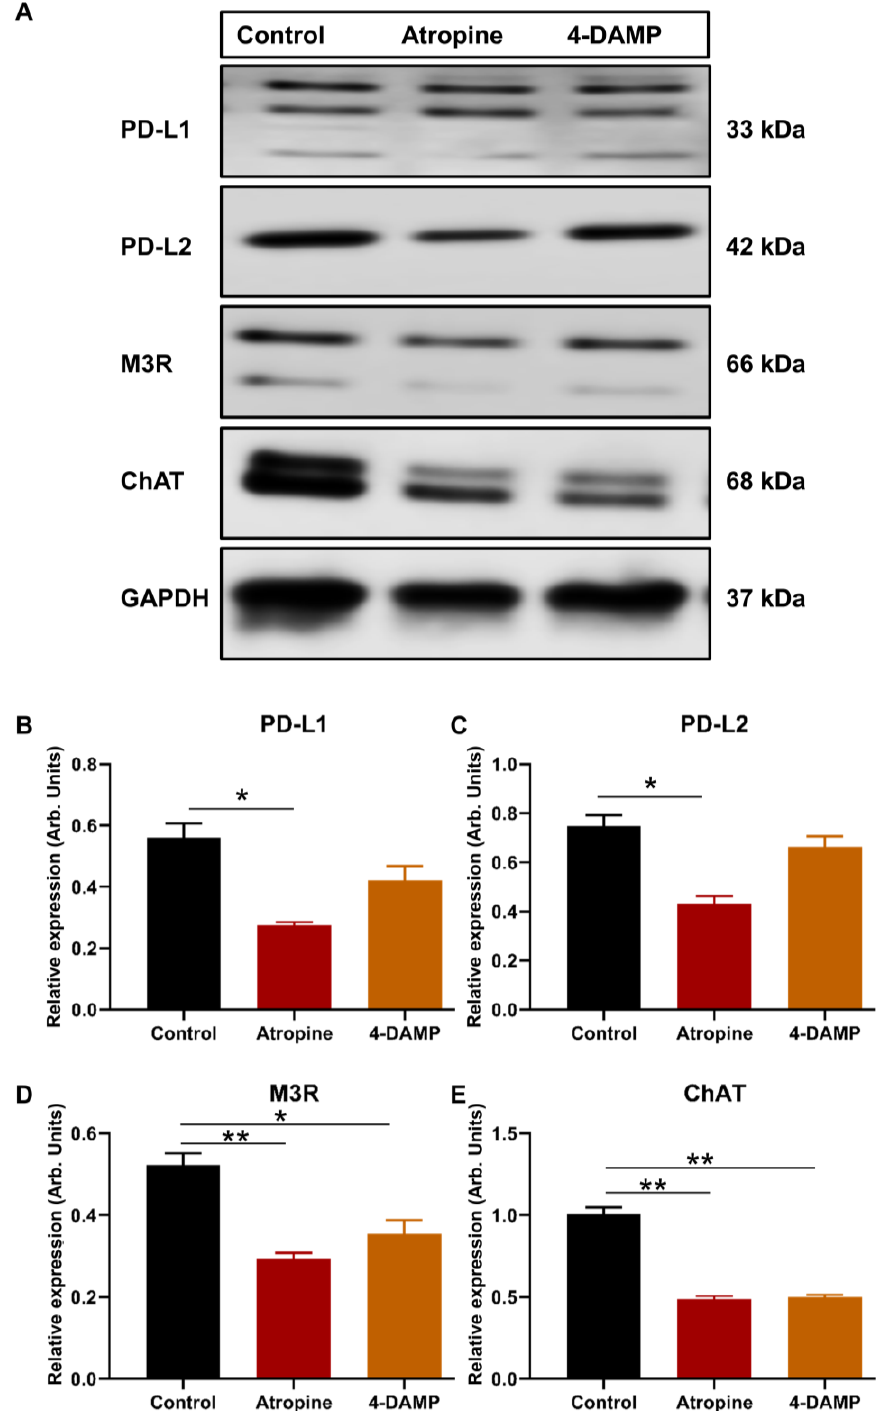
Figure 2. Effect of atropine and 4-DAMP on the expression of immunosuppressive and cholinergic markers in CT-26 cells. Western blot bands for PD-L1 and PD-L2 expression in CT-26 cells treated with atropine and 4-DAMP ( A ). Western blot bands for M3R and ChAT expression in CT-26 cells treated with atropine and 4-DAMP ( A ). Bar graphs displaying the mean intensity of PD-L1 ( B ) and PD-L2 ( C ) expression in CT-26 cells treated with 4-DAMP and atropine. Bar graphs displaying the mean intensity of M3R ( D ) and ChAT ( E ) expression in CT-26 cells treated with 4-DAMP and atropine. Data presented as mean ± SEM. Two-way ANOVA, * p < 0.05, ** p < 0.01. Data presented as mean ± SEM. Two-way ANOVA, * p < 0.05.